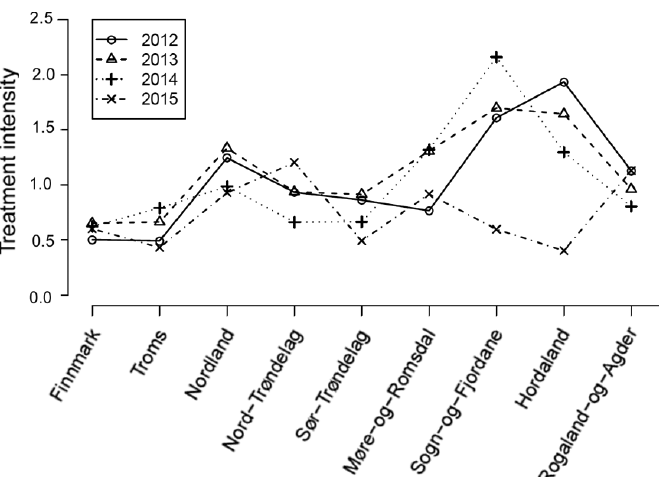
Fig. 2. Pyrethroid treatment intensity on Norwegian fish farms in the period 2012 to 2015. Treatment intensity is given by number of treatments per thousand tons of standing bio- mass at county level. Data collected from BarentsWatch (2017) and Directorate of Fisheries